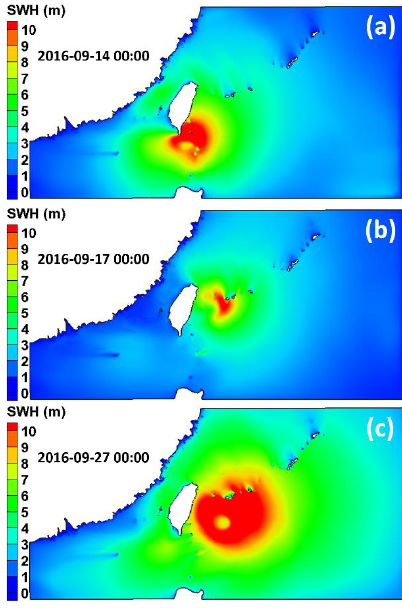
Figure 10. Spatial distribution of the simulated significant wave height at ( a ) 00:00 on 14 September 2016, ( b ) 00:00 on 17 September 2016, and ( c ) 00:00 on 27 September 2016, using the D03 computation domain and ERA5 wind fields.